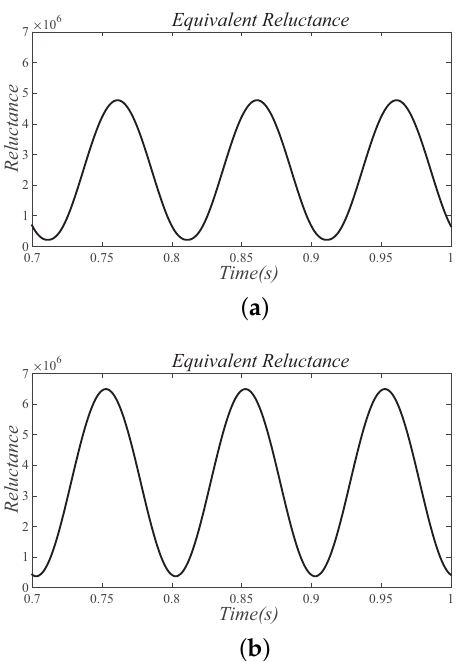
Figure 14. ( a ) The machine with alternate excitation mode, ( b ) the machine with bipole excita- tion mode.